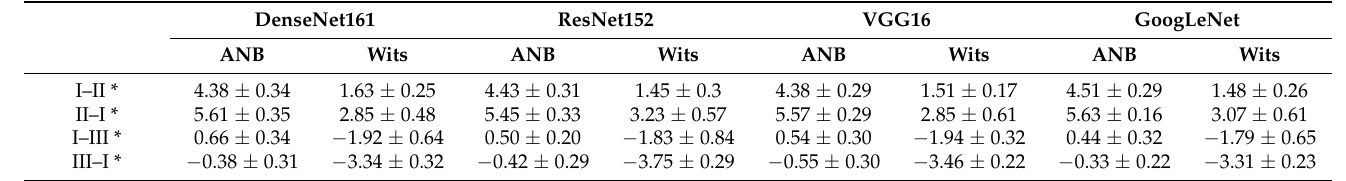
Table 4. The average ANB angles and Wits values of the misjudged samples by the four CNNs. DenseNet161 ResNet152 VGG16 GoogLeNet ANB Wits ANB Wits ANB Wits ANB